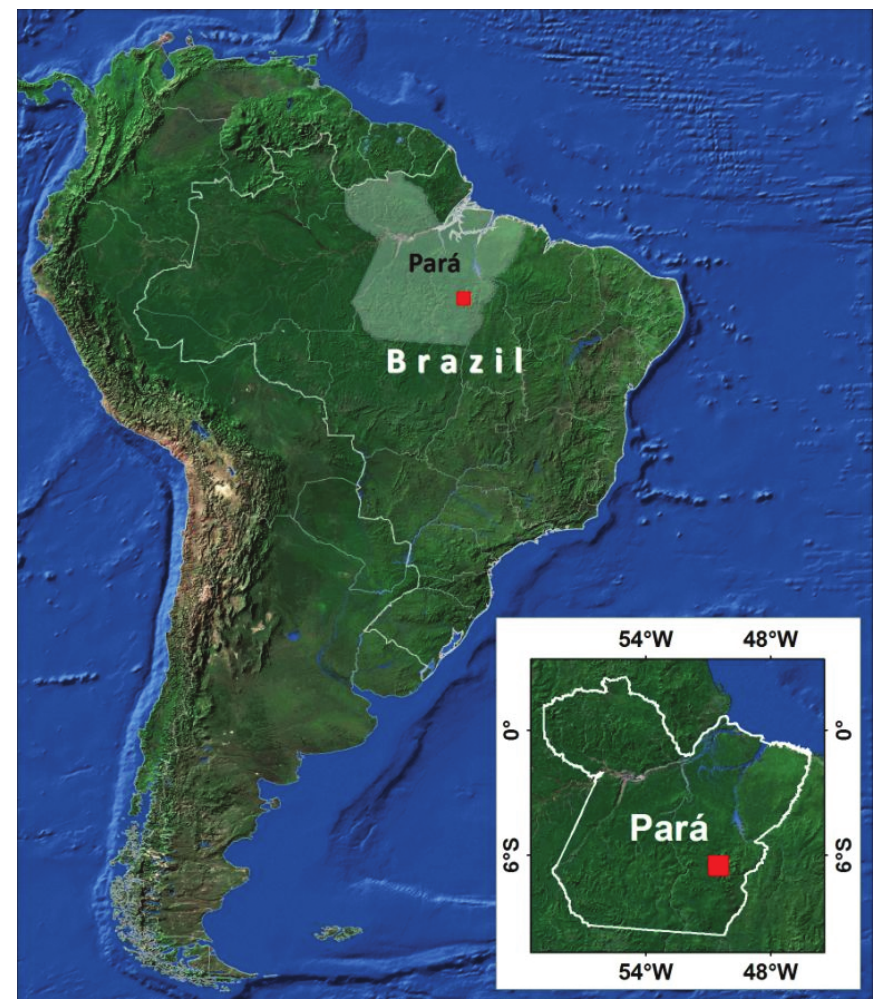
Fig. 1 – Location of the study area in the Pará